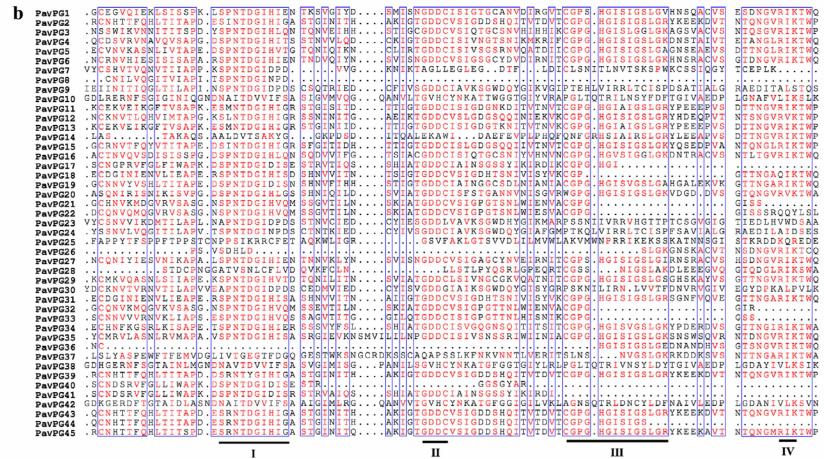
Figure 2. Multiple sequence alignments of the conserved domains of the PavXTHs ( a ) and PavPGs ( b ). The sequences were aligned using the Clustal X software and Espript online program. The black lines indicate the conserved domain. N-glycosylation residues are indicated as